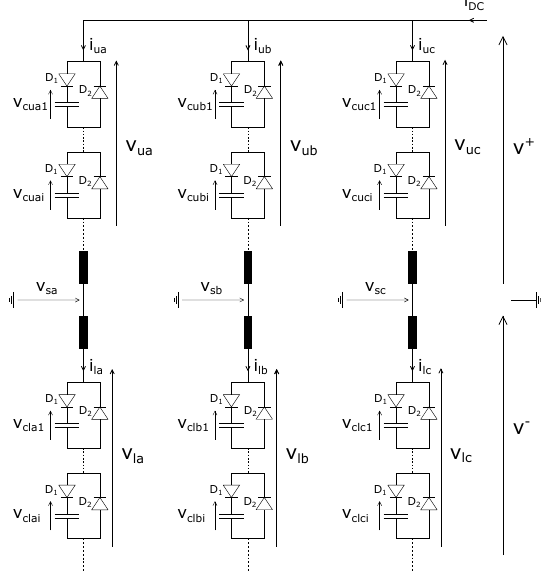
Figure 9. MMC with half-bridge cells after blocking of the controlled devices.